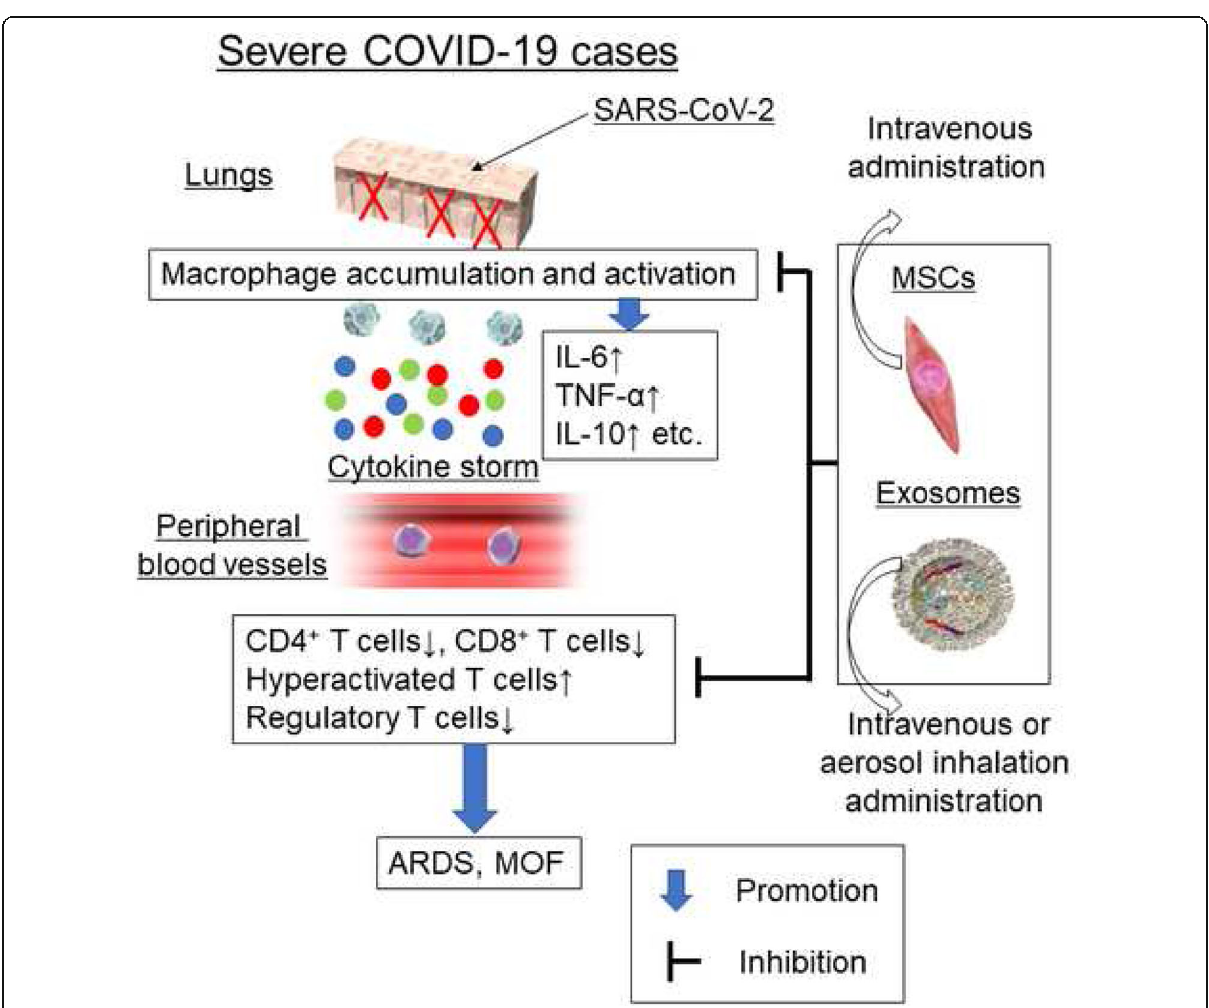
Fig. 1 Putative mechanisms of mesenchymal stem cell (MSC) and exosome therapy in severe COVID-19 cases. MSCs and their exosomes have a potent ability to ameliorate the cytokine storm observed in severe cases of COVID-19, and prevent progression toward acute respiratory distress syndrome (ARDS) and multiple organ failure (MOF). SARS-CoV-2, severe acute respiratory syndrome coronavirus